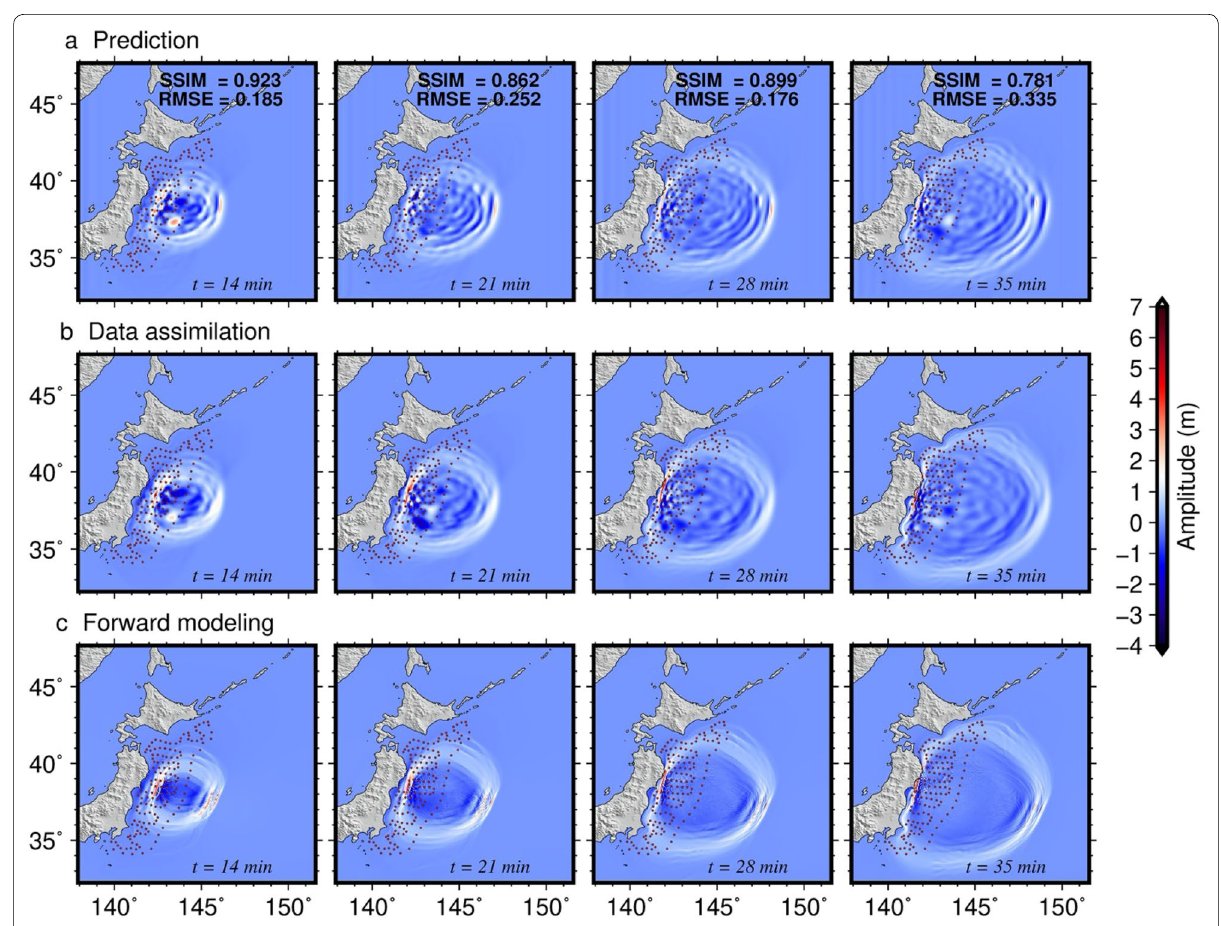
Fig. 9 Comparisons of the estimated wavefields from the proposed method, DA and forward modeling for the 2011 Tohoku tsunami at t 28 and 35 min. a Forecasted tsunami wavefields; b assimilated tsunami wavefields; c results of forward